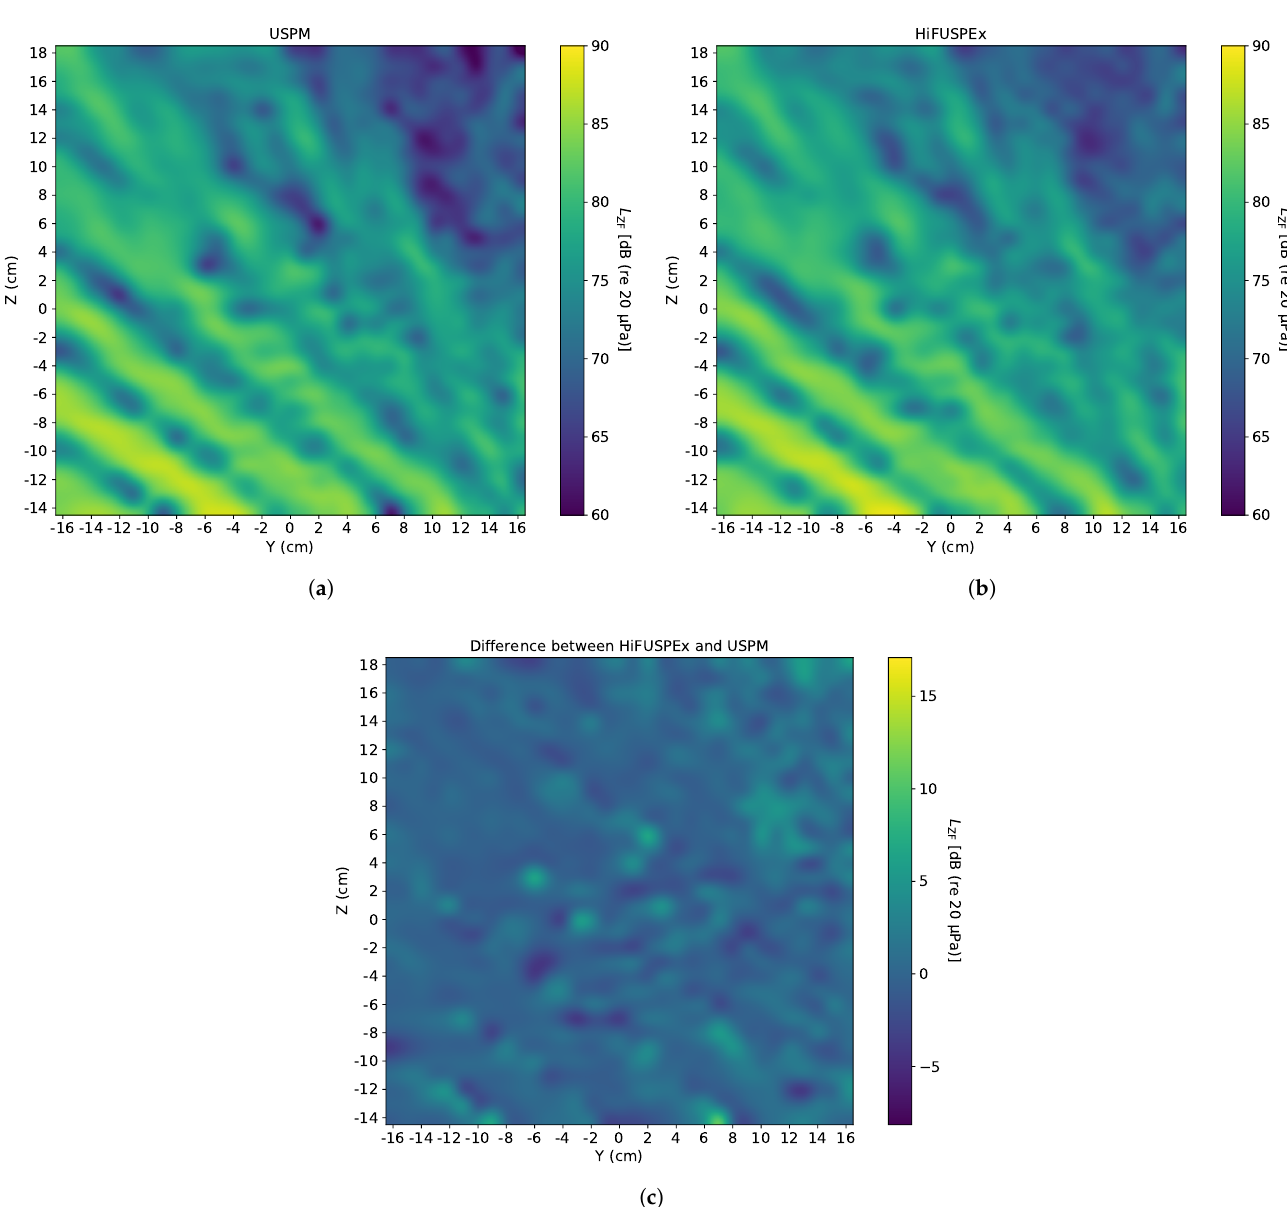
Figure 12. Sound fields within the scanning unit when an idealized signal of a welding machine (20 kHz) was simulated. Results were obtained with the artificial head in the sedentary position and without the protection grid mounted. The pre- sented plots show the sound fields obtained for: ( a ) USPM; ( b ) HiFUSPEx; and ( c ) difference between the HiFUSPEx and the USPM. Please refer to Figure 10 for identification of zy